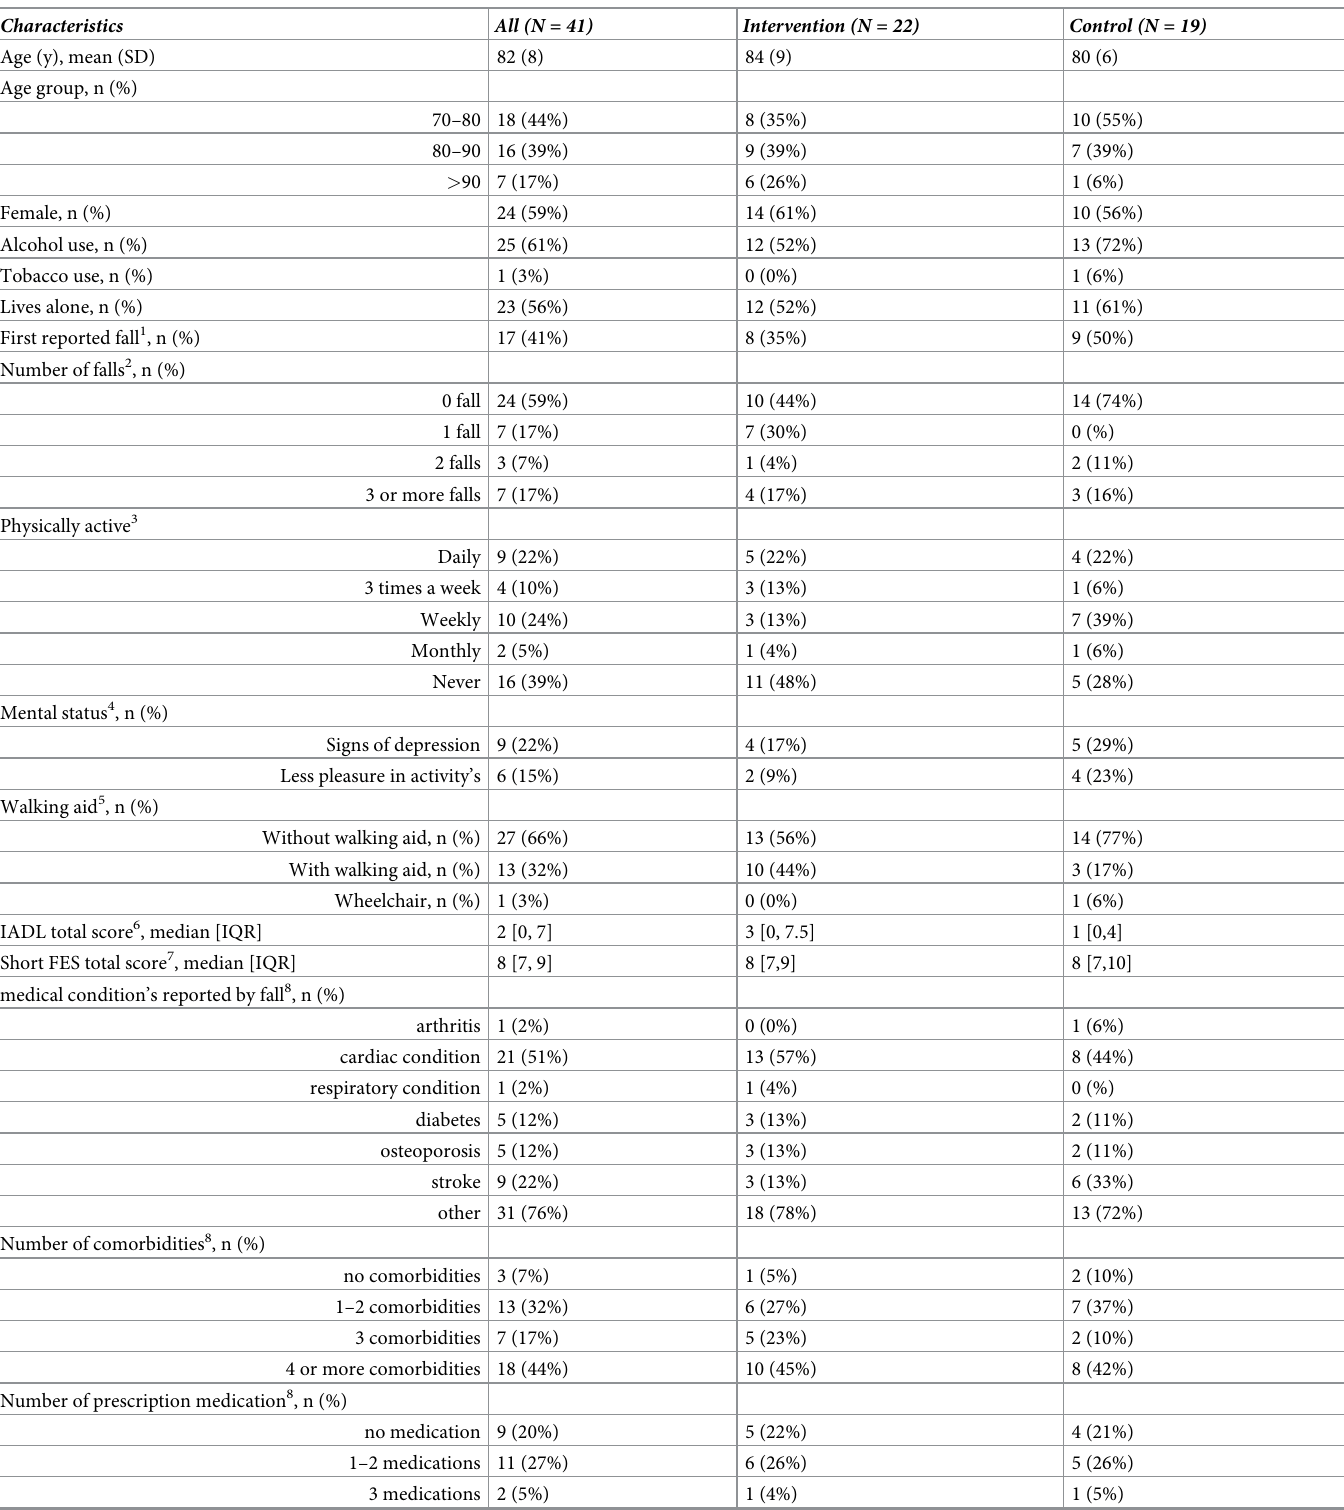
Table 1. Baseline